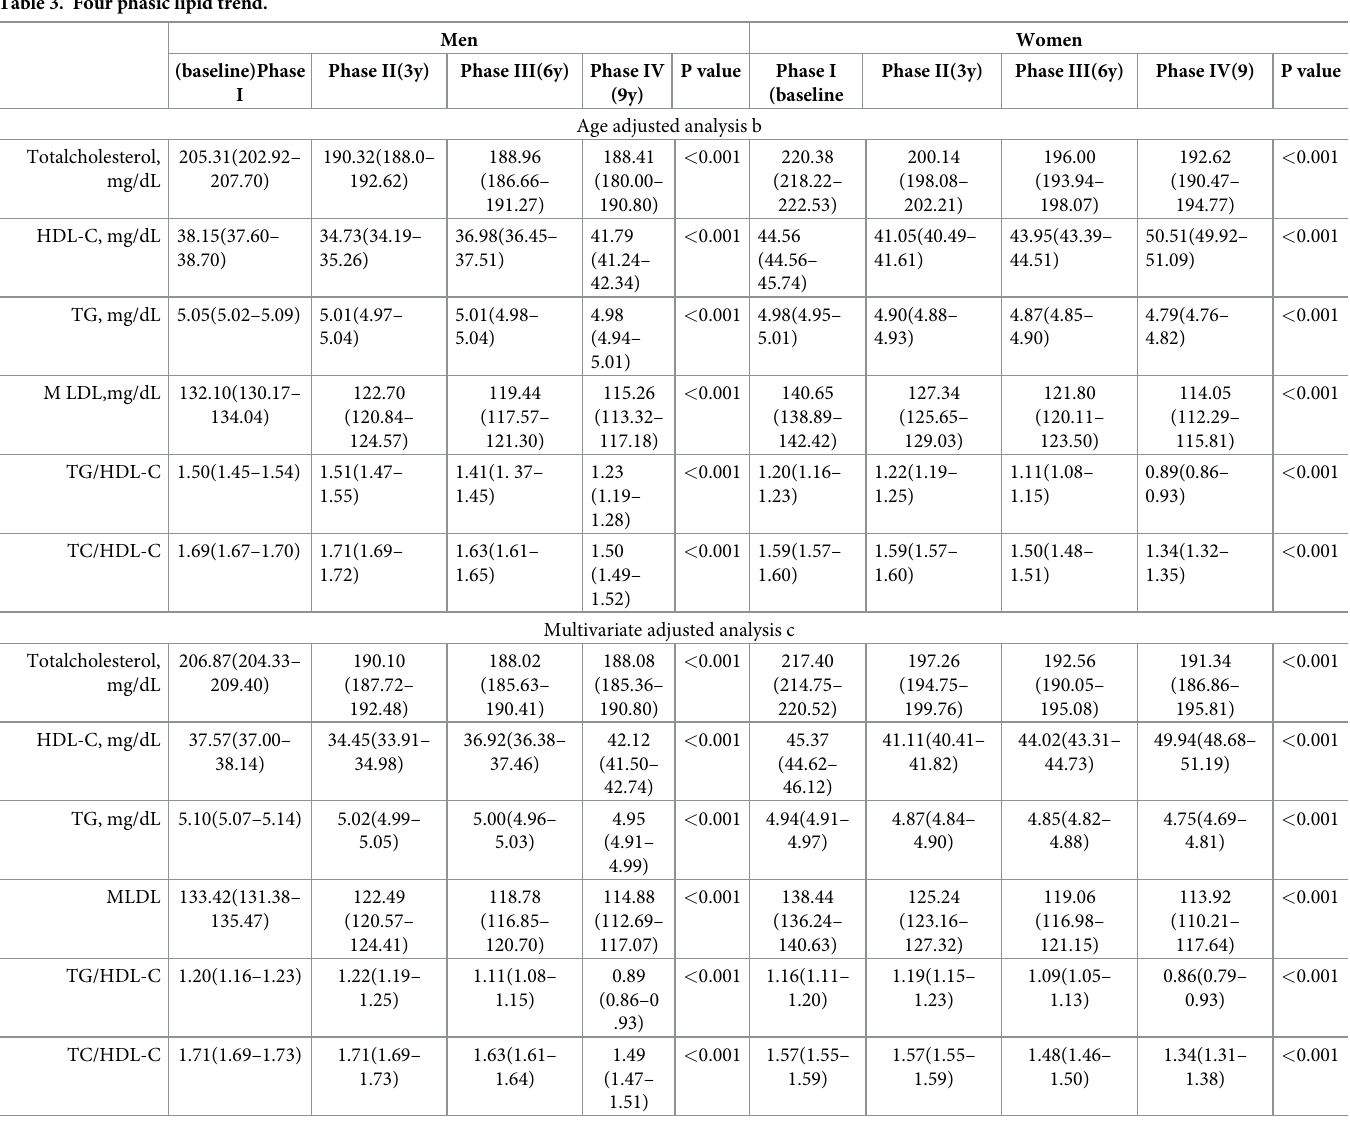
Table 3. Four phasic lipid